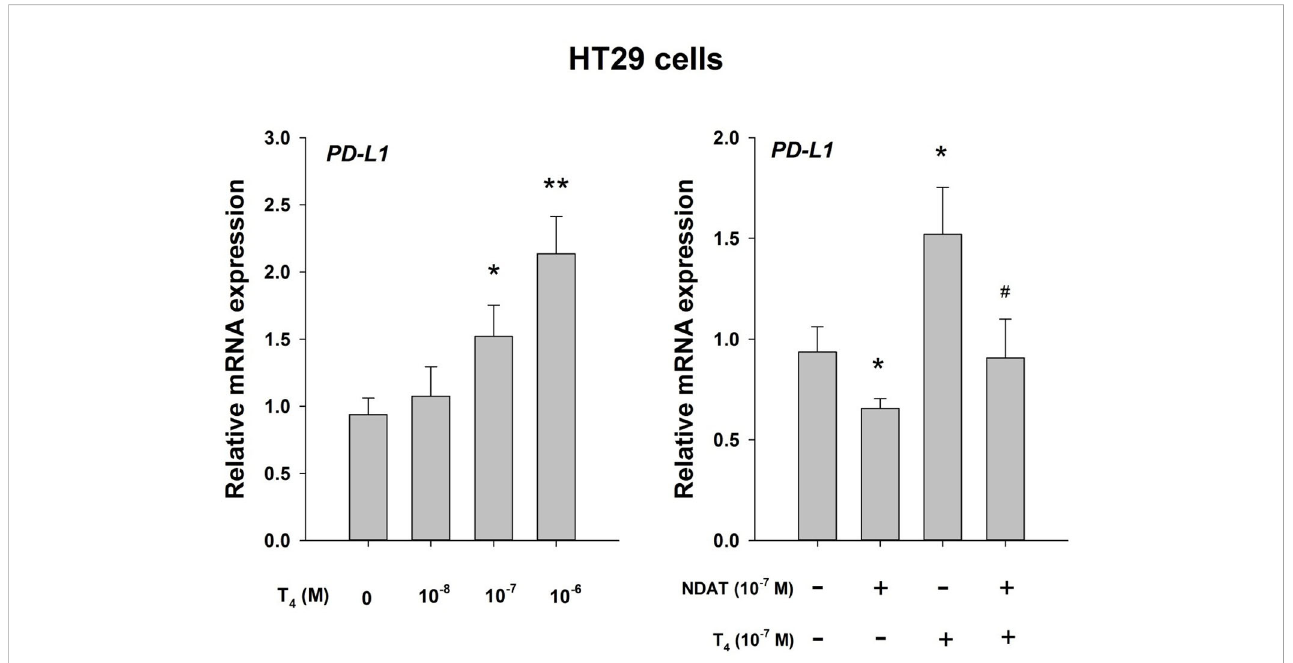
FIGURE 1 Thyroid hormone as T4 inhibits host anticancer immune response via enhanced PD-L1 gene expression. Effect of T4 and the T4 derivative, NDAT (nano- diamino-tetrac), on induction of PD-L1 mRNA in HT-29 human colorectal cancer cells. Hormonal effects are expressed relative to control samples that lacked T4. Left panel, T4 concentration-dependence of PD-L1 mRNA expression with exposure of cells to hormone for 24 h. Right panel, the action of T4 on induction of PD-L1 mRNA is inhbited by NDAT, a speci fi c inhibitor of T4 action at its receptor site on tumor cell surface integrin a v b 3 (3). Reproduced by permission *p < 0.05, **p < 0.01, compared with control; #p < 0.05, compared with T4 at 10-7 M. from HY Lin et al.